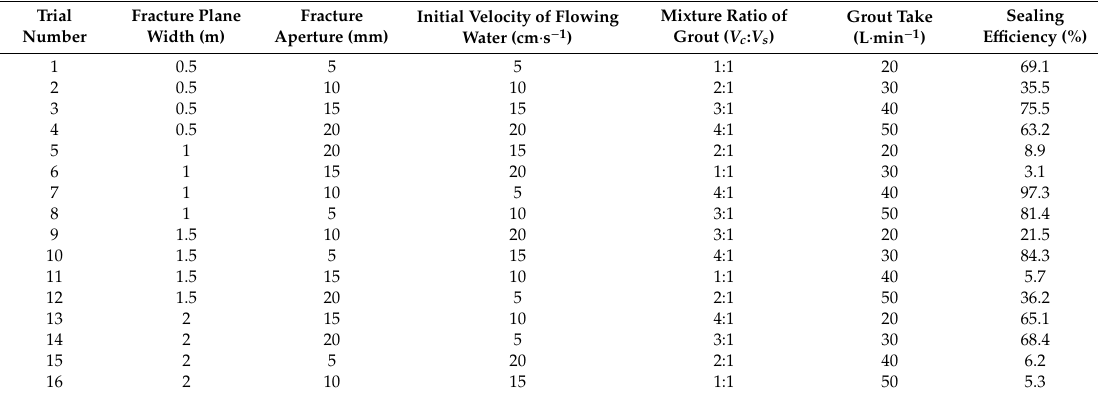
Table 2. Orthogonal arrays and their